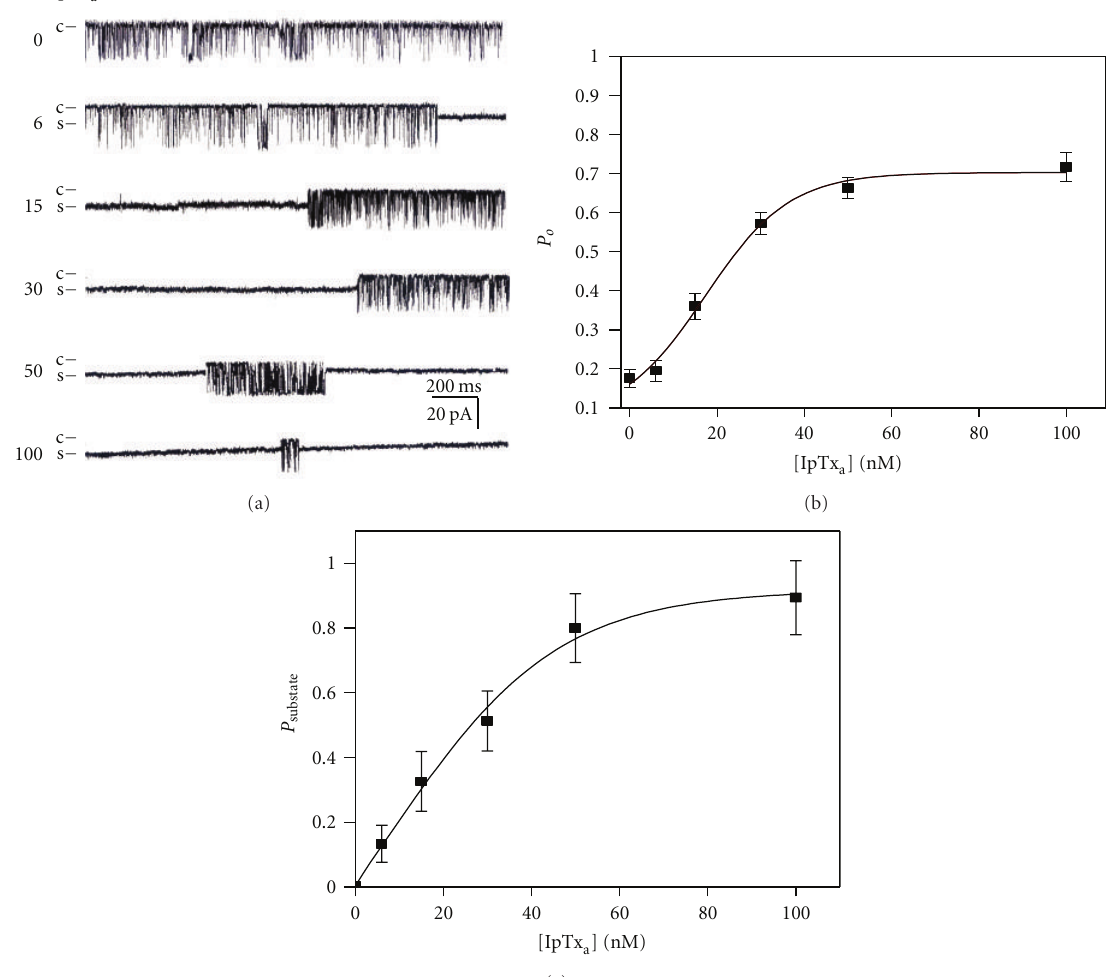
Figure 1: Properties of single channel gating in IpTx a -modified native RyR1. (a) Channel current traces of a single skeletal RyR1 in planar lipid bilayers activated by various concentrations of IpTx a . IpTx a at 6–100 nM (final) was added to the cis solution to activate the channel. Channel openings are shown as downward deflections. Channel activities were recorded at a holding potential of − 30 mV. (b) A plot of P o versus concentration of IpTx a to activate rabbit skeletal RyR1. Data points are means ± SE of ten experiments. (c) A plot of P substate versus IpTx a concentration for rabbit skeletal RyR1. Data points are means ± SE of 9